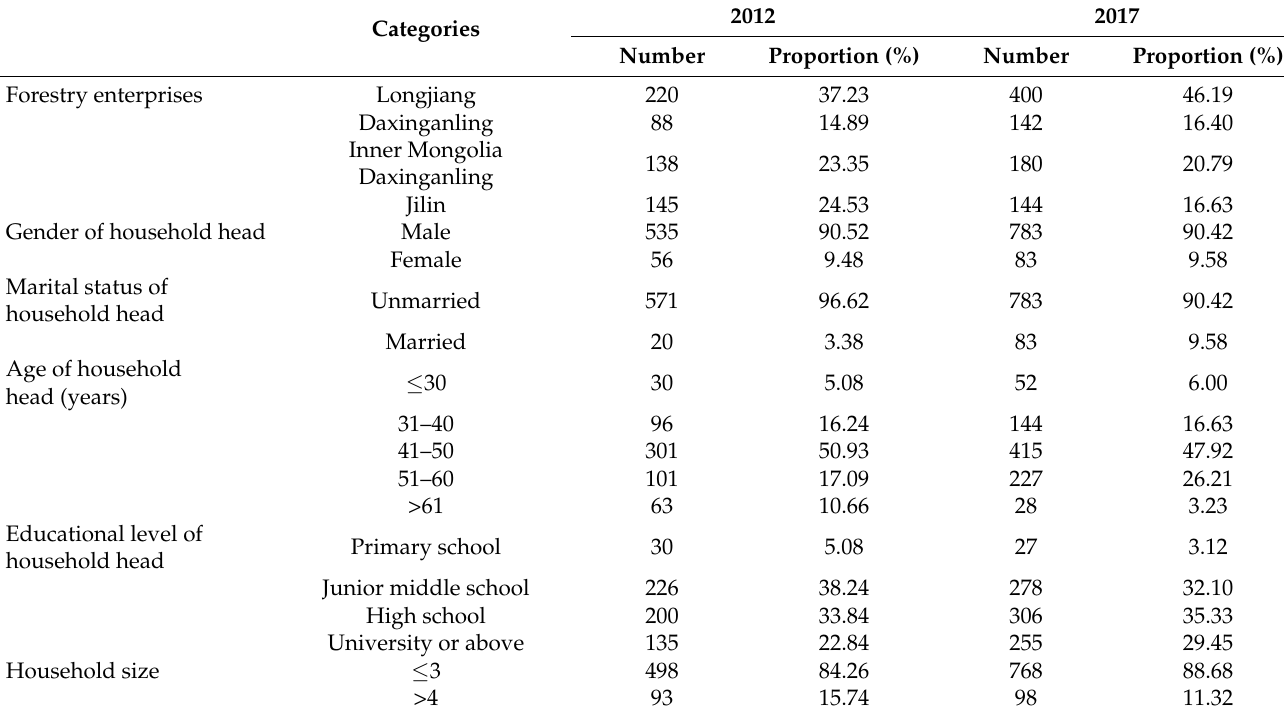
Table 2. Basic characteristics of survey